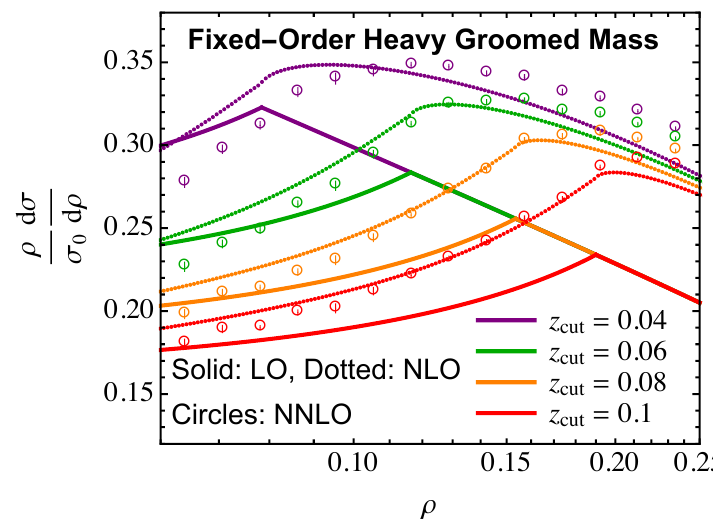
Figure 2 . Plots of the leading, next-to-leading and next-to-next-to-leading (cid:12)xed order cross sections of the heavy hemisphere groomed mass, with z cut = 0 : 04 ; 0 : 06 ; 0 : 08 ; 0 : 1. These plots focus